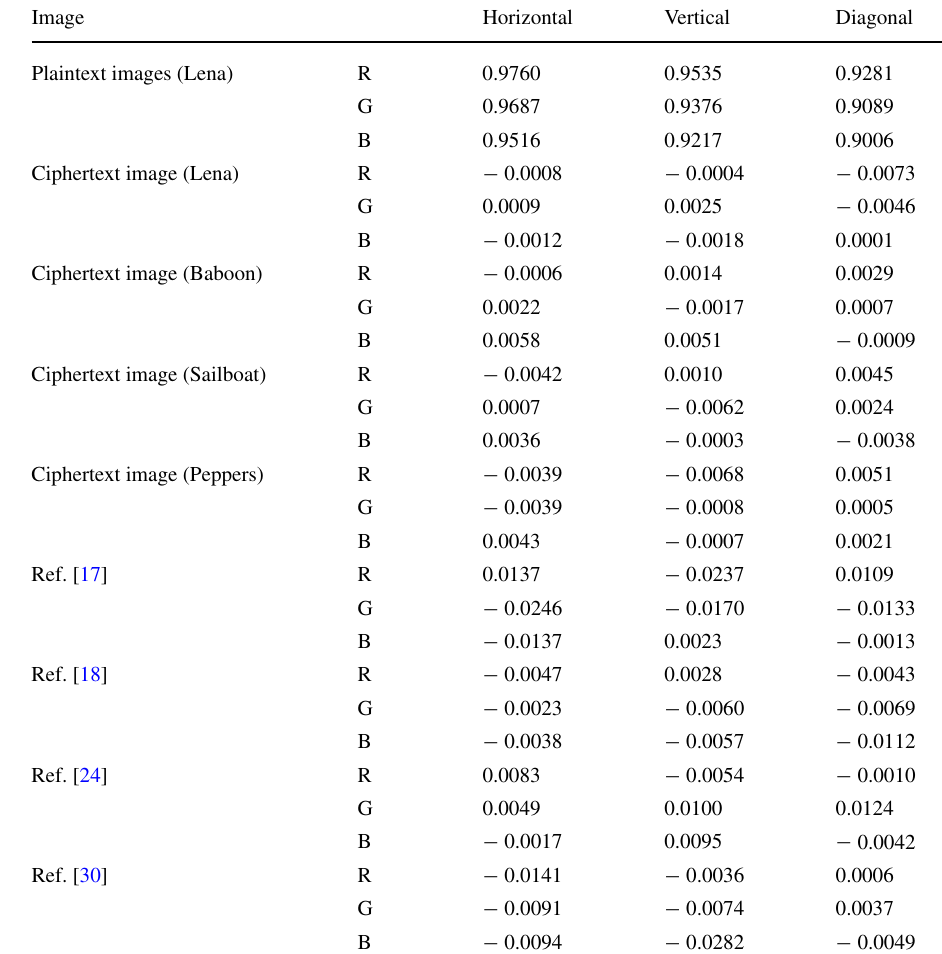
Table 6 Correlation coefficients of adjacent pixels in plaintext images and ciphertext